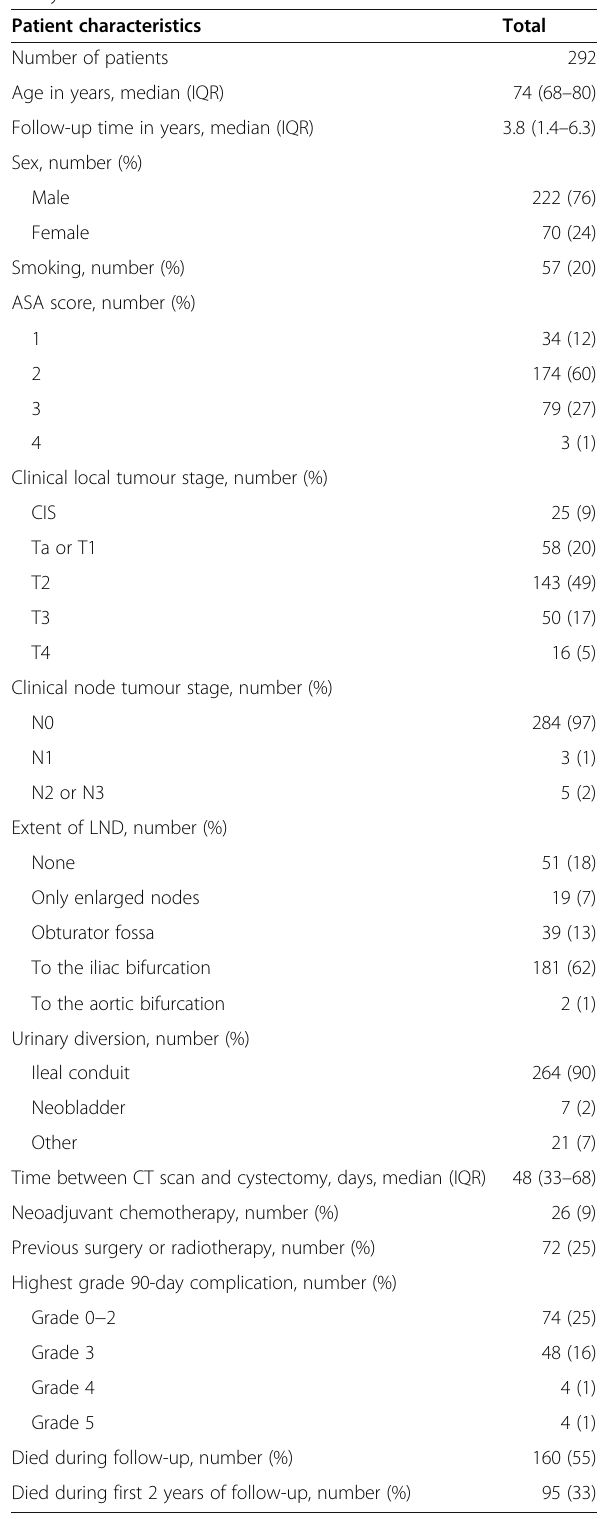
Table 1 Clinical characteristics of the patients included in the